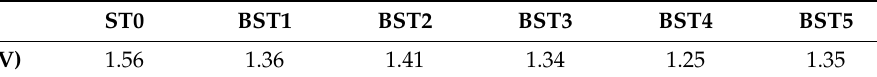
Table 2. The band gaps of Bi-Ti/Si-X composite films.